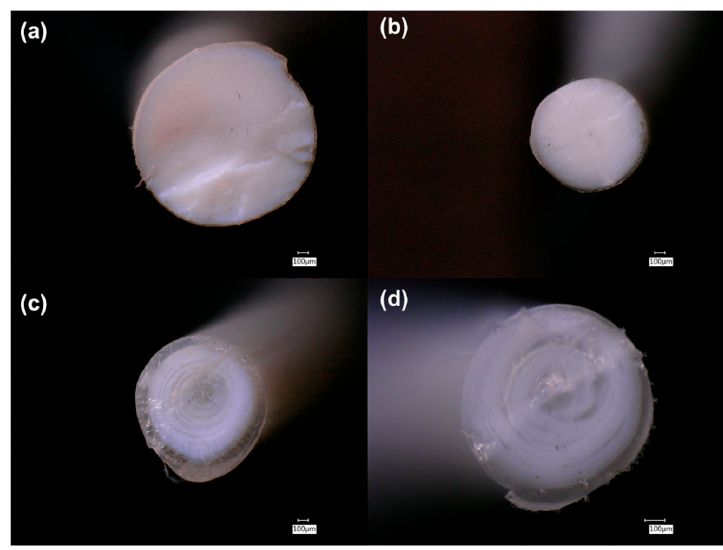
Figure 1. Digital microscopy cross-section images of: ( a ) PLA/TiO 2 90/10; ( b ) PLA/ZnO 90/10; ( c ) PLA/TiO 2 /PEG2k 80/10/10; and ( d ) PLA/ZnO/PEG2k 80/10/10.